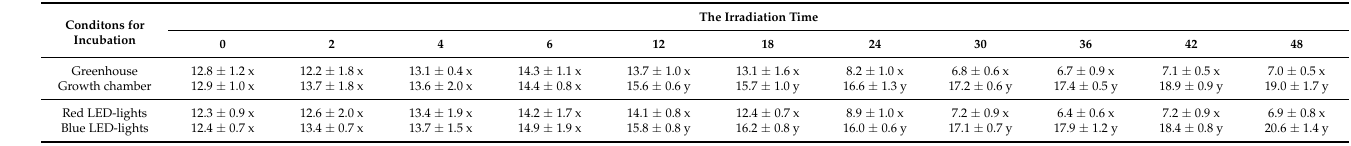
Table 2. Number of conidia remaining on KMP-6N conidiophores following the collection of progeny conidia using an electrostatic spore collector (insulator